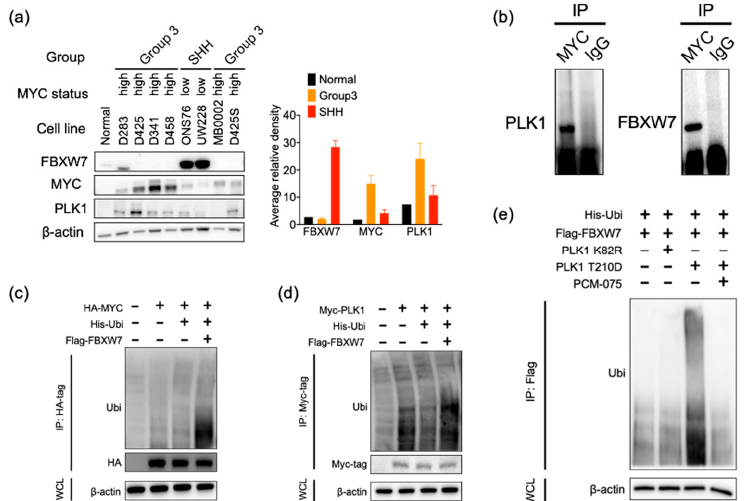
Figure 3. PLK1-MYC-FBXW7 regulatory loop in medulloblastoma. ( a ) Western blot analysis of FBXW7, c-MYC, and PLK1 in medulloblastoma cell lines. The protein was normalized with β -actin on the same membrane (left). Quantification bar blot of Western blots (right). The quantification for each protein can be found in Figure S2. ( b ) Endogenous interaction between c-MYC with PLK1 and FBXW7. Lysates from D458 cells were subjected to immunoprecipitation using an anti-c-MYC antibody, and proteins that co-precipitated with c-MYC were detected by immunoblot using anti- PLK1 or anti-FBXW7 antibodies. ( c , d ) FBXW7 promotes PLK1 and c-MYC ubiquitination. The HA293 cells were transfected with plasmids expressing Myc tag PLK1 or HA tag c-Myc, His-ubiquitin and Flag tag FBXW7. Cell lysates were immunoprecipitated with specific Myc tag or HA tag antibodies, and the ubiquitin protein levels were analyzed by immunoblot. β -actin was used as a loading control. ( e ) FBXW7 poly-ubiquitination in the presence or absence of PLK1 mutants. HEK293 cells were transfected with plasmids expressing ubiquitin, Flag tag FBXW7 and constitutively active PLK1 (PLK1-T210D) or kinase inactive mutant PLK1 (PLK1-K82R), as indicated, followed by lysis in an IP buffer. A ubiquitin-conjugated FBXW7 protein was immunoprecipitated with a FLAG tag antibody and subjected to an immunoblot assay with a ubiquitin antibody. β -actin was used as a loading control. The original blots are in Figure